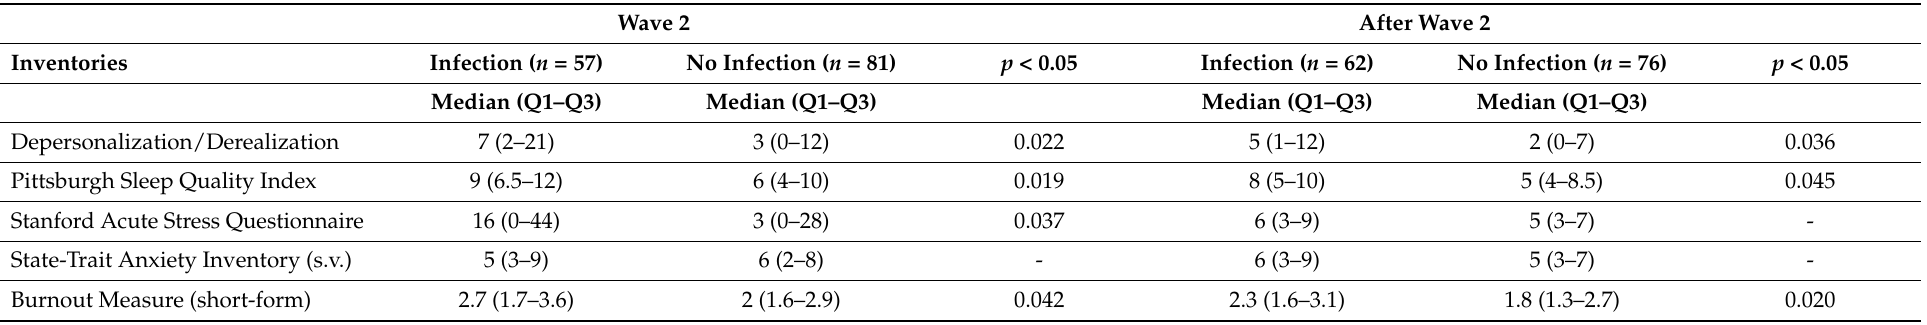
Table 3. Median and quartiles 1 and 3 (Q1–Q3) of the inventory scores of 138 participants during the second epidemic wave, according to SARS-CoV-2 infection. Comparisons were performed using the Mann–Whitney “ U ”